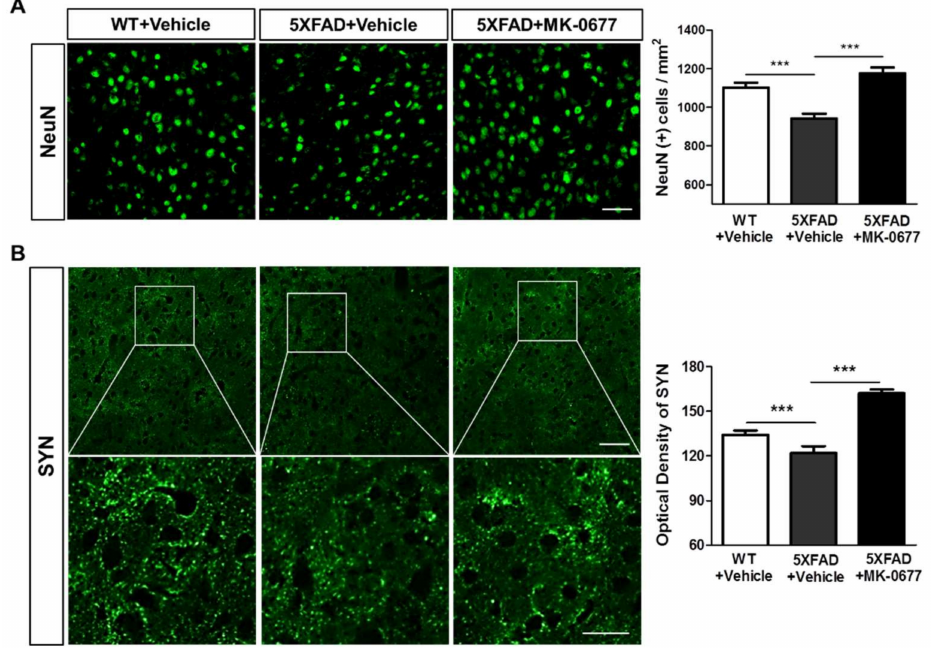
Figure 3. MK-0677-treated 5XFAD mice exhibited a significant reduction in neurodegeneration compared with the vehicle group. Immunofluorescent staining was performed to detect the markers of neuronal cells (NeuN) and pre-synaptic terminals (SYN) in layer V of the frontal cortex of wild-type ( n = 8) and 5XFAD mice. MK-0677 significantly ameliorated the reduction of the number of NeuN (+) cells ( A ) and optical density of SYN (+) area ( B ) in 5XFAD mice ( n = 6), compared with vehicle-treated 5XFAD mice ( n = 7). *** p < 0.001 indicates significant differences between the groups. Scale bars are 50 µ m in the upper panel and 25 µ m in the lower